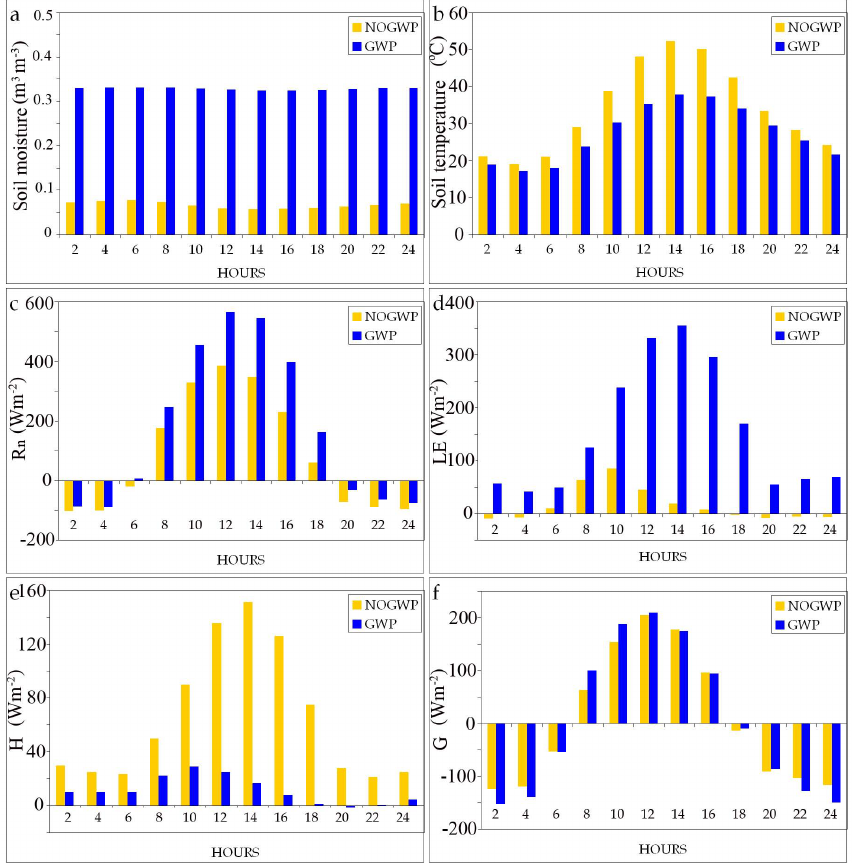
Fig. 5. The surface soil moisture, the surface soil temperature and the surface energy balance components of the two profiles on a summer day (16 July of the simulated